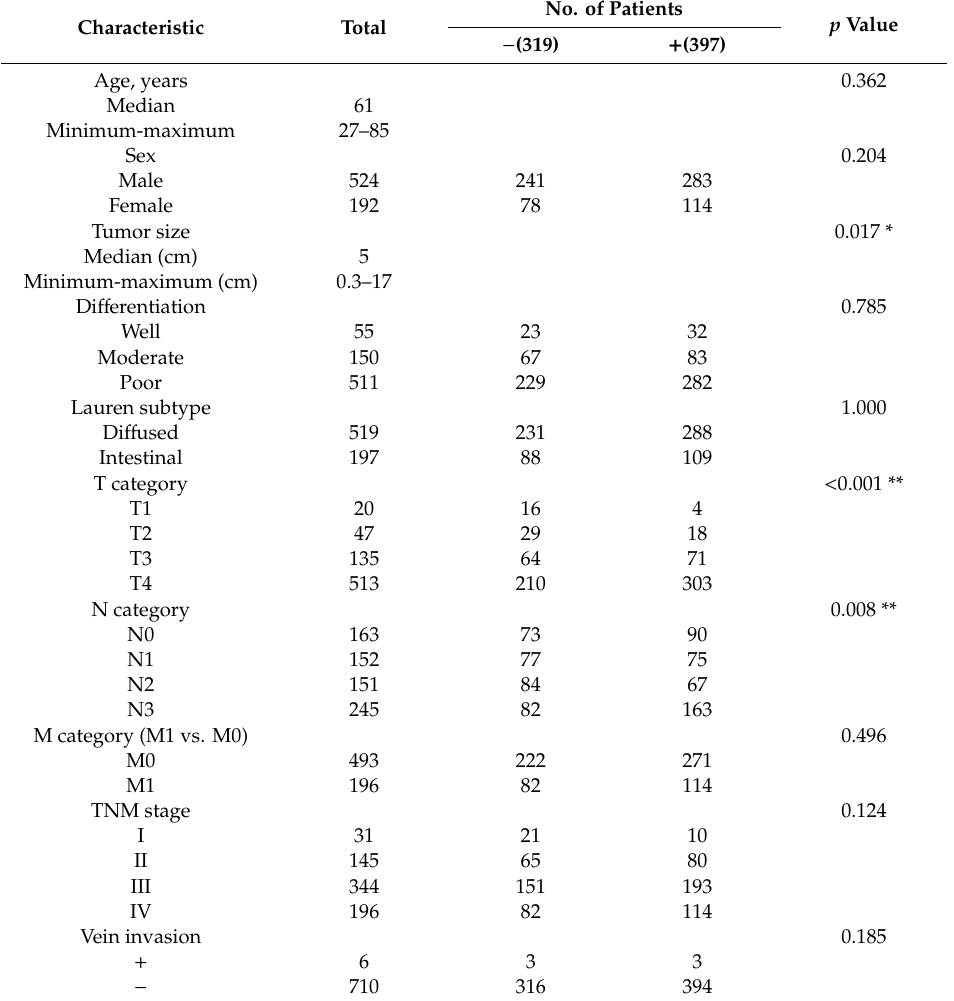
Table 1. Correlation between positive PVT1 expression and clinic-pathologic characteristics. Characteristic Total